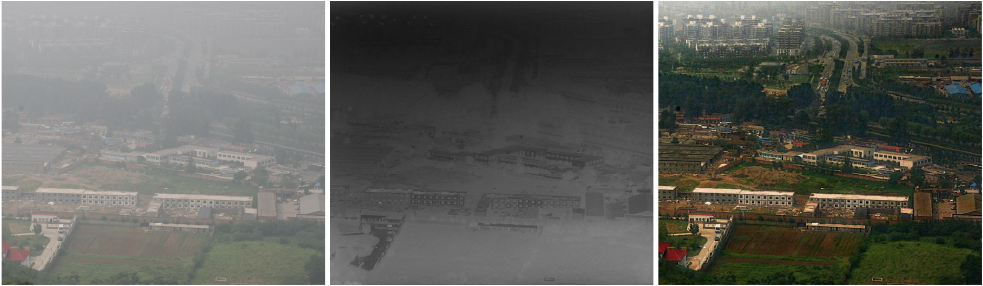
Figure 1. An illustration of our proposed single image dehazing method on a real-world image. From left to right: the hazy input, the estimated transmission map by the proposed algorithm, and the dehazed